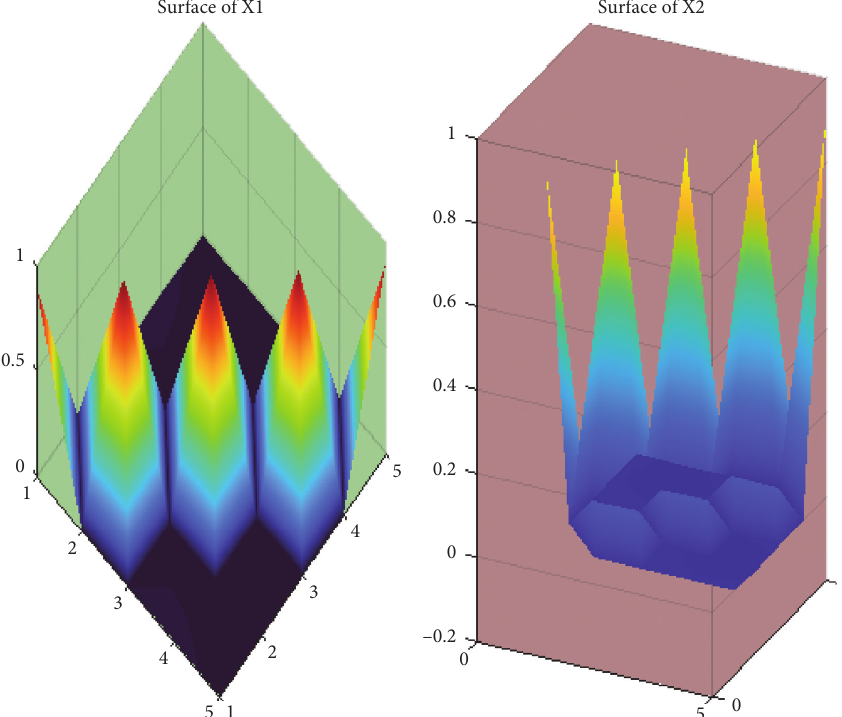
Figure 10: Solution surface plot for dimension 5.